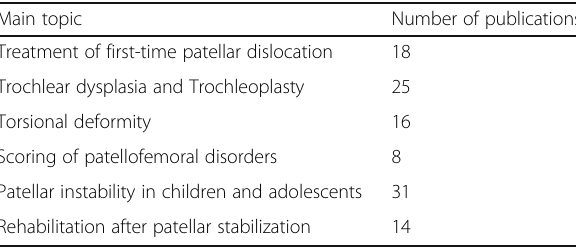
Table 1 Selected main subjects containg potential new aspects of patellar instability with number of publications (January